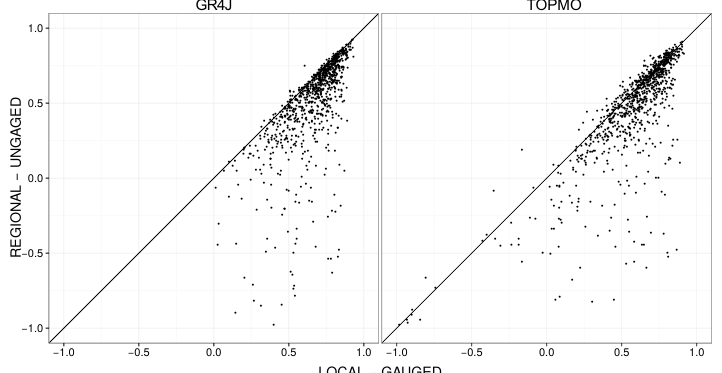
Figure 3. Impact of the regionalisation scheme on deterministic performance, as quantified by the bounded C2M efficiency criterion. Note that in a very few cases, the performance obtained with the regionalisation scheme is better than the performance obtained with calibration. This is possible because of the output averaging option used by the regionalisation scheme.